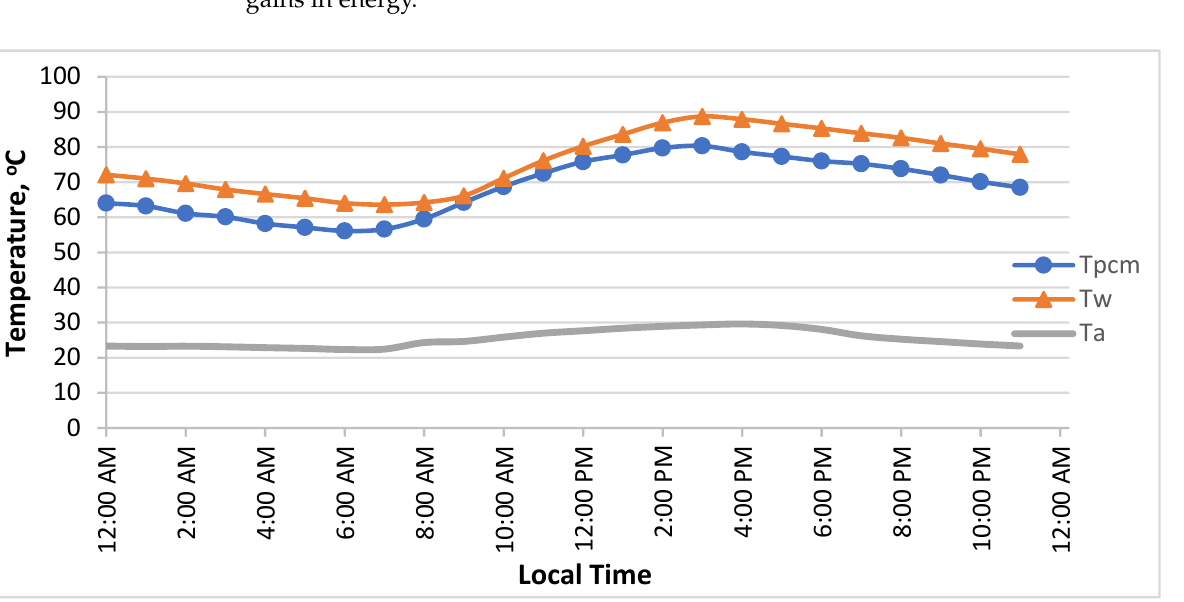
Figure 8. Temperature history of the system through complete hot water consumption. The water and PCM reach the same temperature at a specific point in time. Addition- ally, the temperature of the water in the domestic use range can be considered optimal. This experiment shows the exchange of stored thermal energy in PCMs with water and its effect on water temperature. This experiment explains the family’s sudden and complete drain of the hot water from the water storage tank and how the PCM raises the water temperature by 10 ◦ C over a short period of time. Furthermore, Figure 9 shows the temperature distributions of hot water, PCM, and ambient temperature in the absence of hot water consumption throughout the day. This experiment was performed in approximately similar weather conditions to the previous one. It can be noticed that higher values of hot water and PCM temperatures are due to the absence of load energy. Moreover, it is clear that the temperature difference between water and paraffin is small; this difference is less than 1 ◦ C in the morning hours with increasing gains in energy.